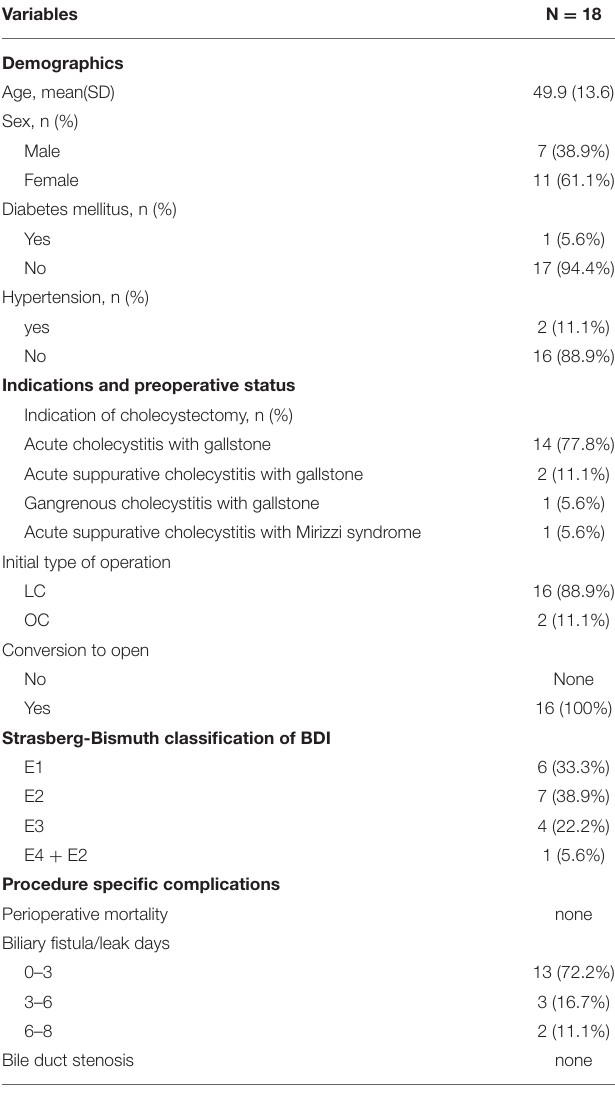
TABLE 1 | Demographics and clinical